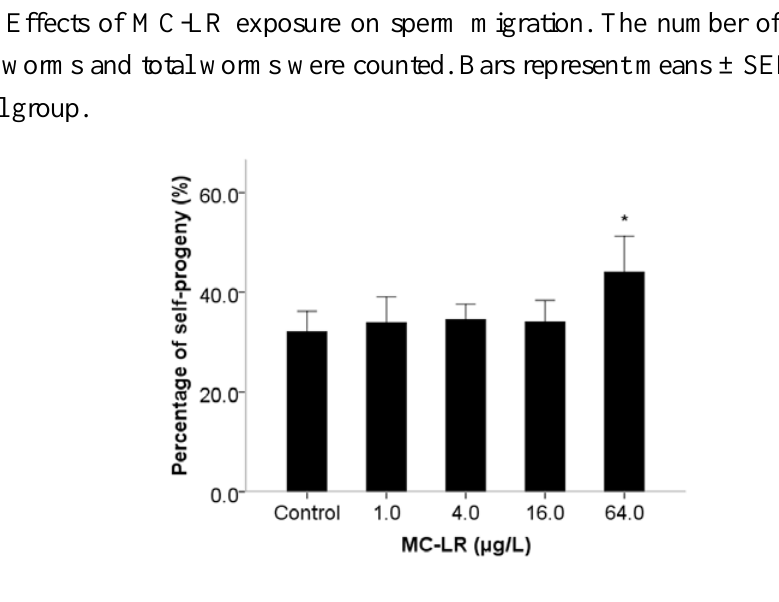
Figure 5. Effects of MC-LR exposure on sperm competitiveness. The number of self-progeny and outcrossed-progeny were counted. Bars represent means ± SEM. * p < 0.05 vs . the control